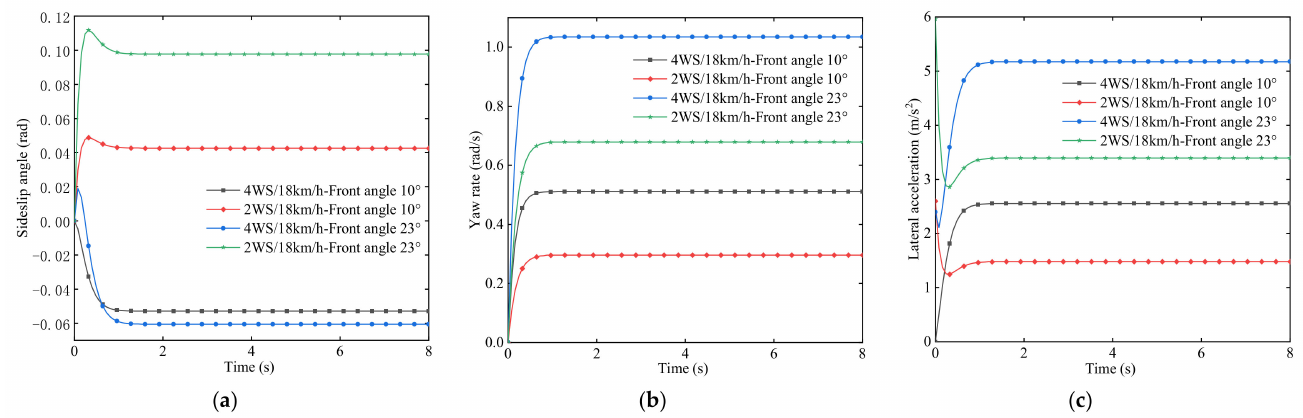
Figure 14. Comparative analysis of different rotation angles at low speeds. ( a ) Sideslip angle. ( b ) Yaw rate. ( c ) Lateral